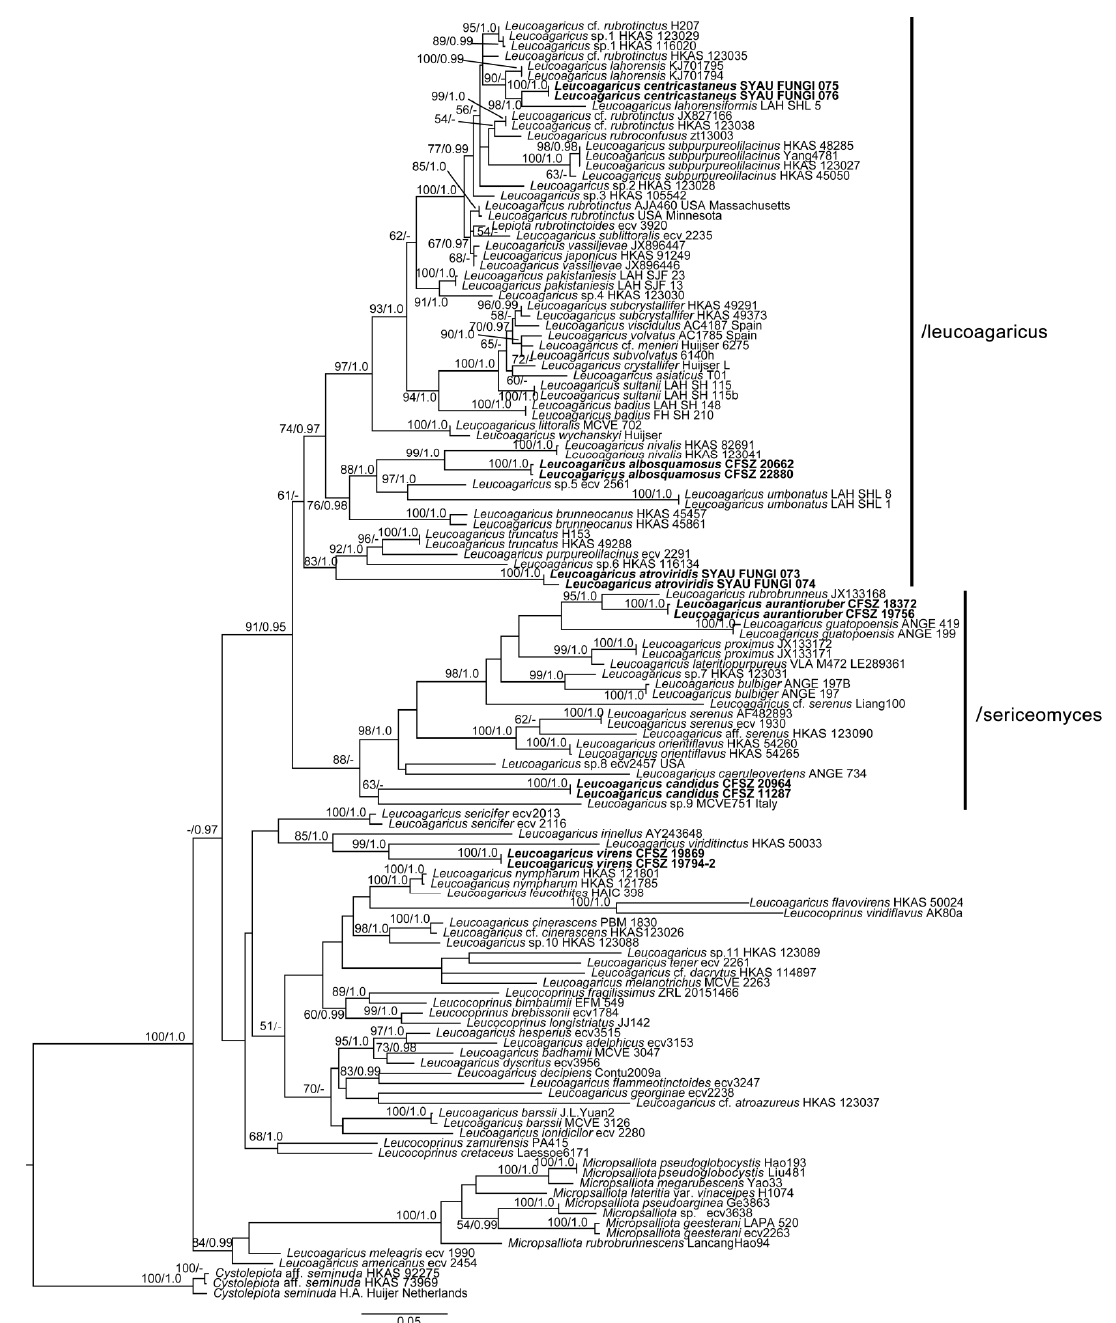
Figure 1. ML tree inferred from the combined dataset of ITS and LSU sequences. Statistic support values are indicated on the nodes as ML bootstrap value (BS)/Bayesian posterior probability (PP). BS > 50% and PP > 0.95 are shown on the supported branches. New species are shown in bold. Based on the phylogenetic analyses of the combined dataset, the genera Leucoagaricus , Leucocoprinus and Micropsalliota together form a monophyletic clade (BS = 100%, PP = 1.0),